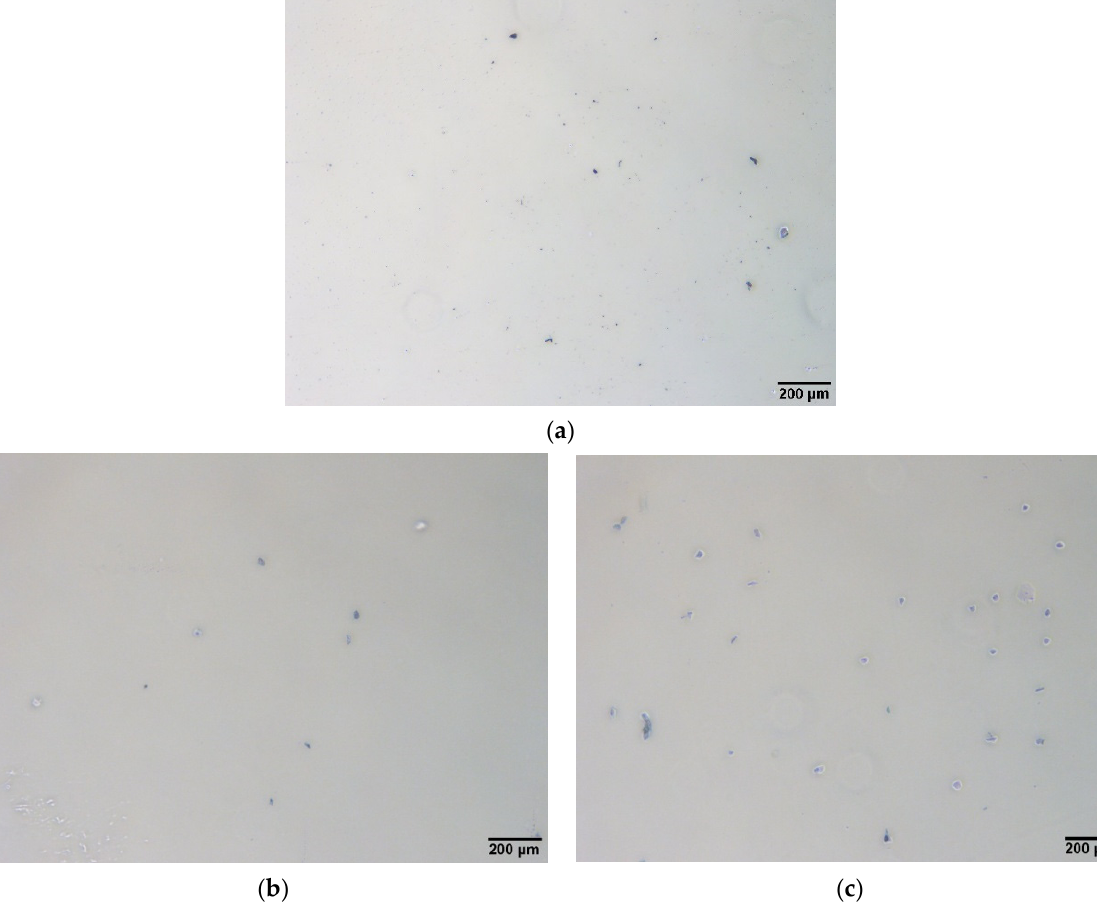
Figure 2. Observation of the prepared micro-plastics by a microscope. After grinding and filtering the plastic standard, micro-plastics with an average particle size of 20 μ m were obtained; then, the morphology of these micro-plastics was observed using an inverted microscope. ( a ) PS, ( b ) PE and ( c ) PVC.